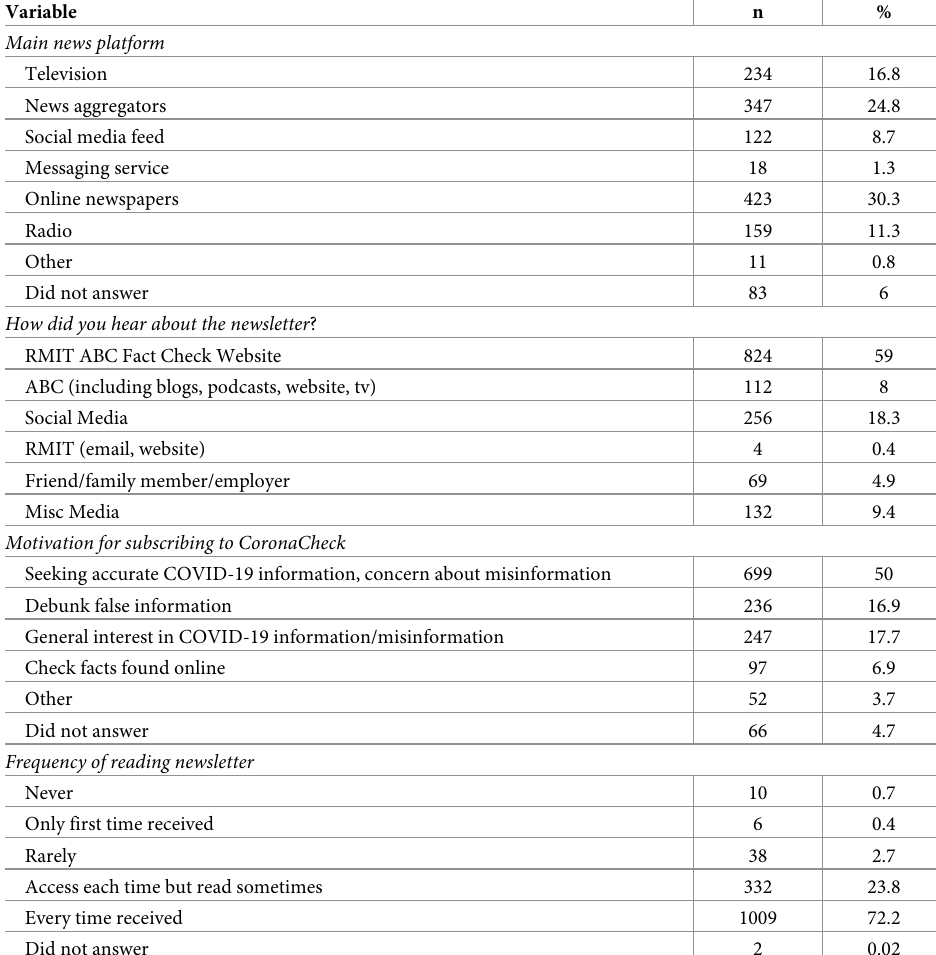
Table 2. Engagement with news and CoronaCheck